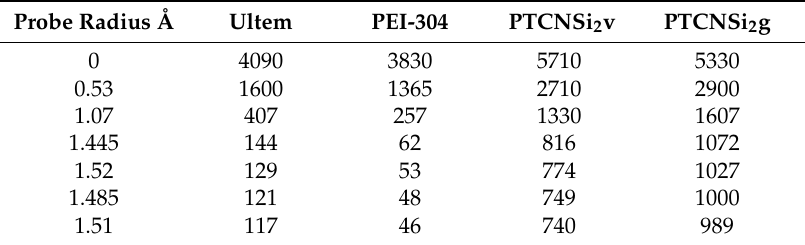
Table 4. Specific surface area S/m (m 2 /g).